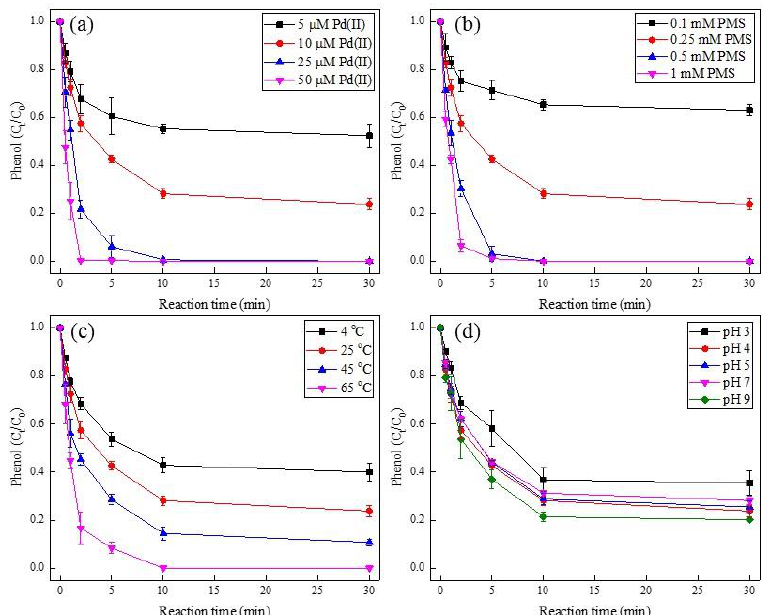
Figure 1. Effect of Pd(II) dosage ( a ), PMS concentration ( b ), reaction temperature ( c ), and initial pH ( d ) on the degradation of phenol. Condition: ( a ). [phenol] = 50 µ M, [PMS] = 0.25 mM, pH i = 4; ( b ). [phenol] = 50 µ M, [Pd(II)] = 10 µ M, pH i = 4; ( c ). [phenol] = 50 µ M, [PMS] = 0.25 mM, [Pd(II)] = 10 µ M, pH i = 4; ( d ). [phenol] = 50 µ M, [PMS] = 0.25 mM, [Pd(II)] = 10 µ